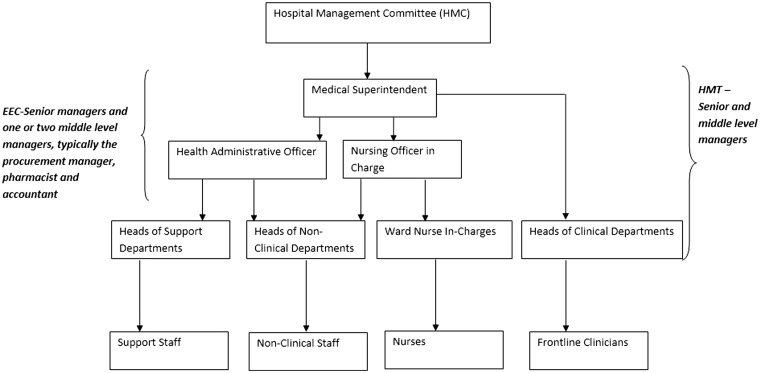
Hospital Organogram